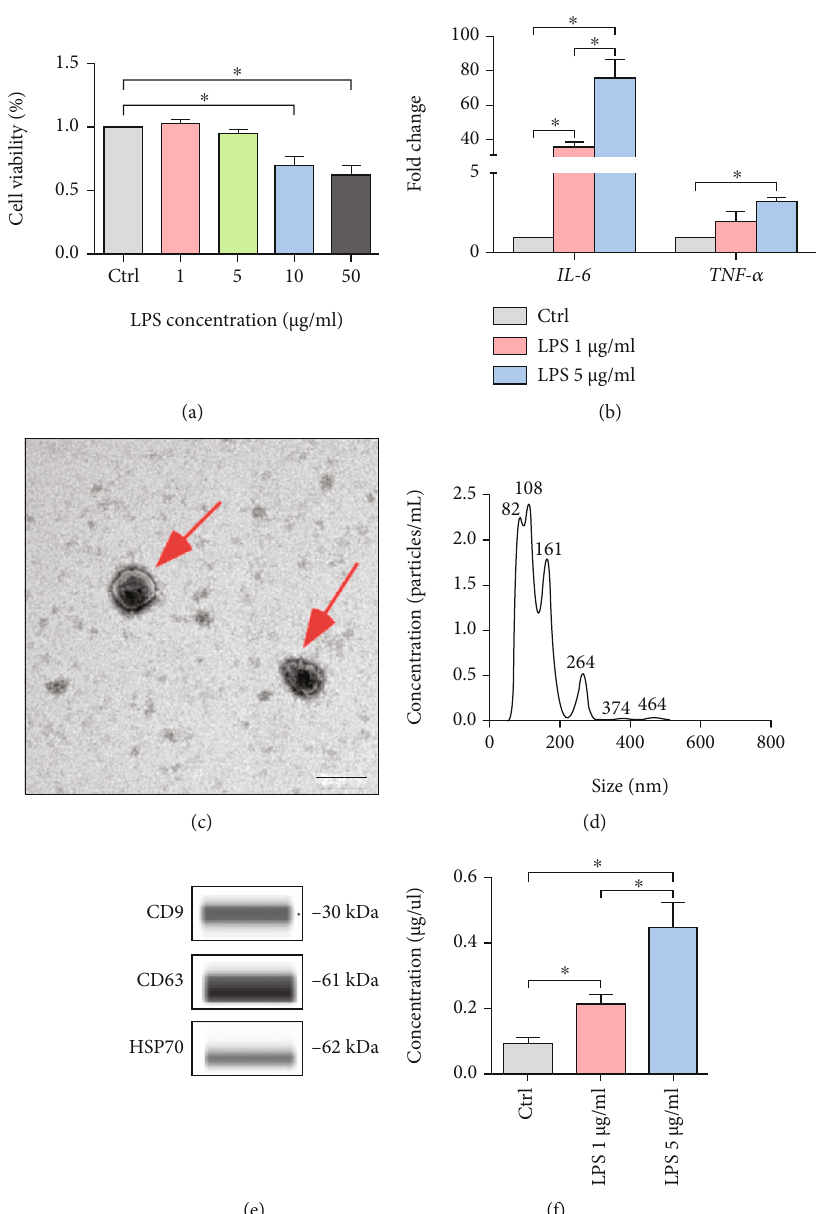
Figure 3: Extraction of exosomes derived from LPS-stimulated hDPSCs. (a) hDPSCs were treated with di ff erent concentrations of LPS for 2 days; cell viability was detected by the CCK-8 assay ( n = 3 ). (b) The IL-6 and TNF- α mRNA expression in LPS-stimulated hDPSCs was detected by qRT-PCR ( n = 3 ). (c) TEM showed the classic morphology of exosomes from hDPSCs, which resembled a cup and saucer and had a bilayer membrane (scale bar, 200nm). (d) The size of the EVs was detected by NTA. (e) The expression of the exosomal surface markers CD9, CD63, and HSP70 was detected by Western blotting. (f) The volume of exosomes secreted from hDPSCs treated with di ff erent concentrations of LPS was detected by BCA assay ( n = 3 ). Data represent means ± SD . ∗ P < 0 : 05